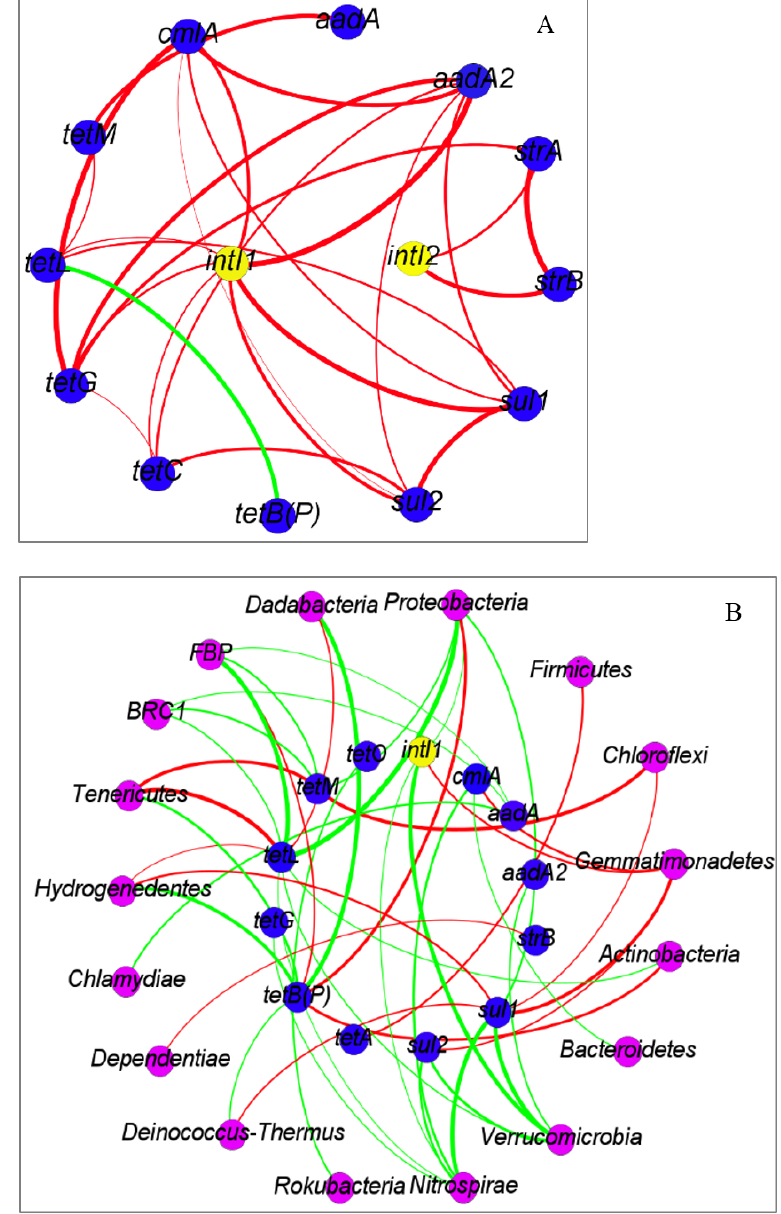
Figure 5. Network analysis of correlation (( A )—the relationship of ARGs and intI genes; ( B )—the relationships of ARGs and intI genes with bacteria). Edges are weighted according to the correlation coefficient. Red edges mean positive correlation, green edges mean negative correlation. Only significant correlation is shown ( p < 0.05).